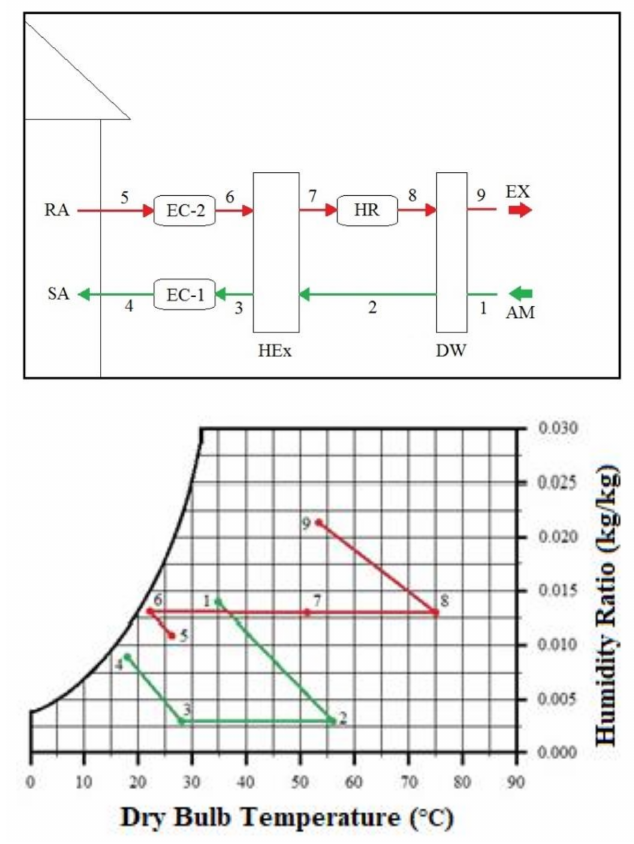
Figure 2. Pennington